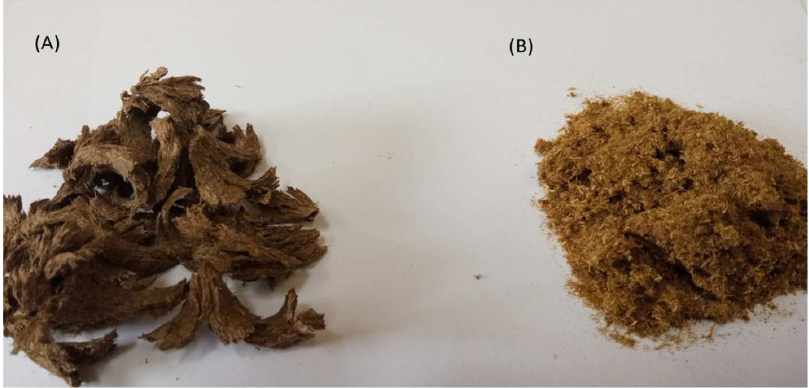
Figure 2. View of obtained sample extrudates: ( A ) from buckwheat straw; ( B ) from rapeseed straw.